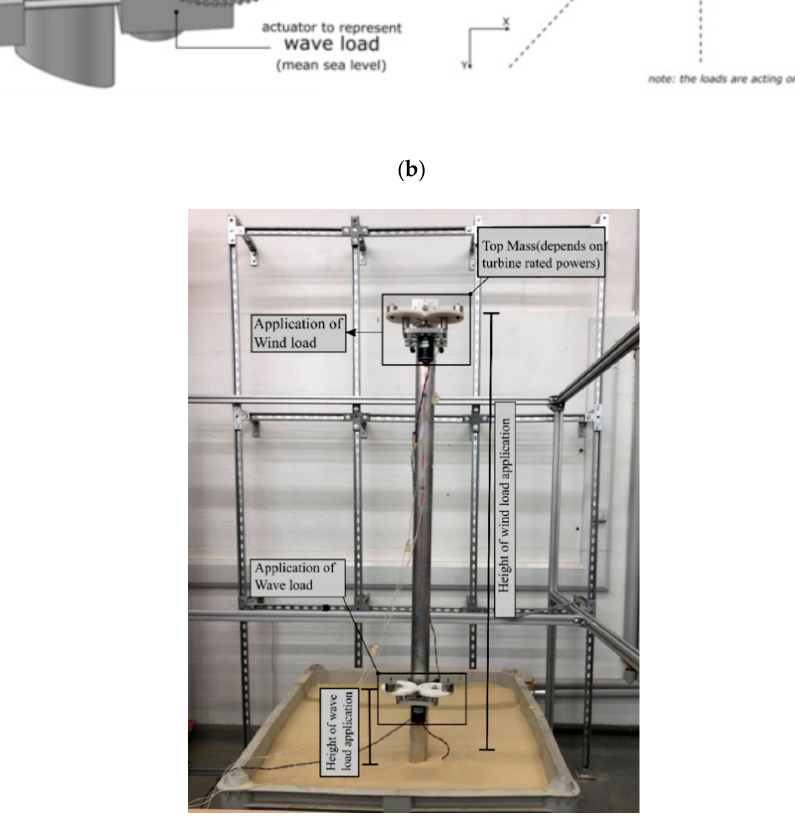
Figure 15. ( a ) Whole system modelling with an eccentric mass actuator (Type 3 technique). ( b ) Working principle of the loading device. ( c ) Example application of the Type 3 Technique.